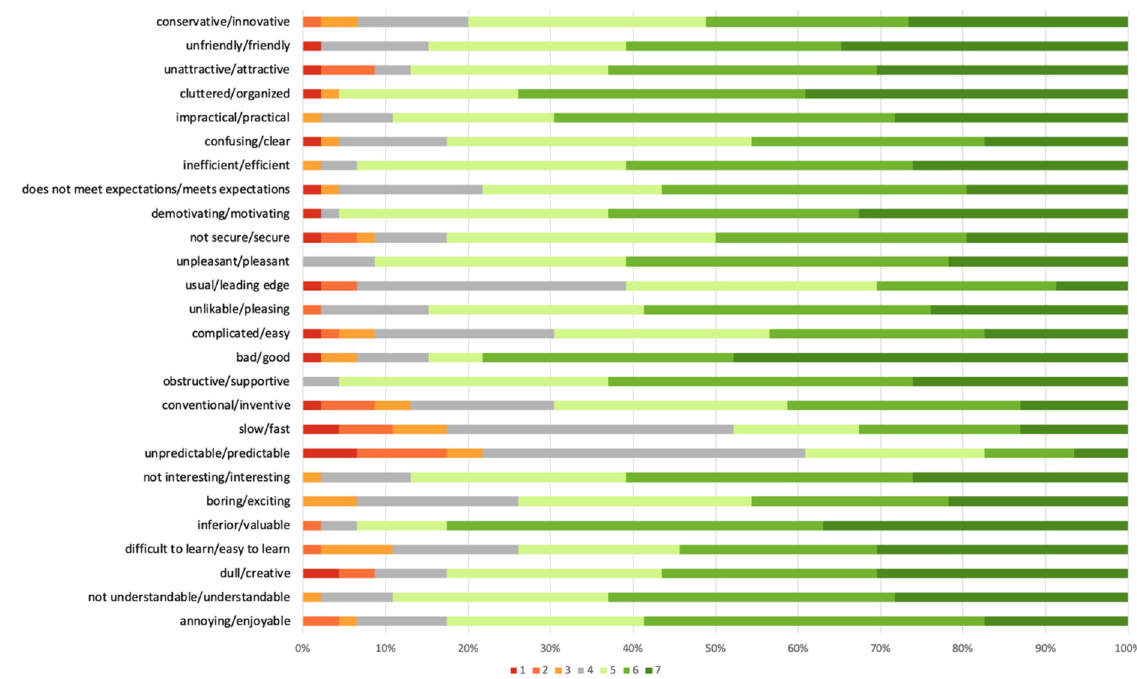
Fig 4. Distribution of participants’ answers across the 7-point scale are presented for each of the 26 items in the user experience questionnaire. Colour coding varies based on the positive or negative attributes chosen to reflect user perspectives of the e-Learning platform. Colour-coding varied across the 7-point scale from 1 (dark red) suggesting a negative rating against the item (e.g. very conservative or very unfriendly) to 7 (dark green) suggesting a positive rating against the item (e.g. very innovative, very friendly).